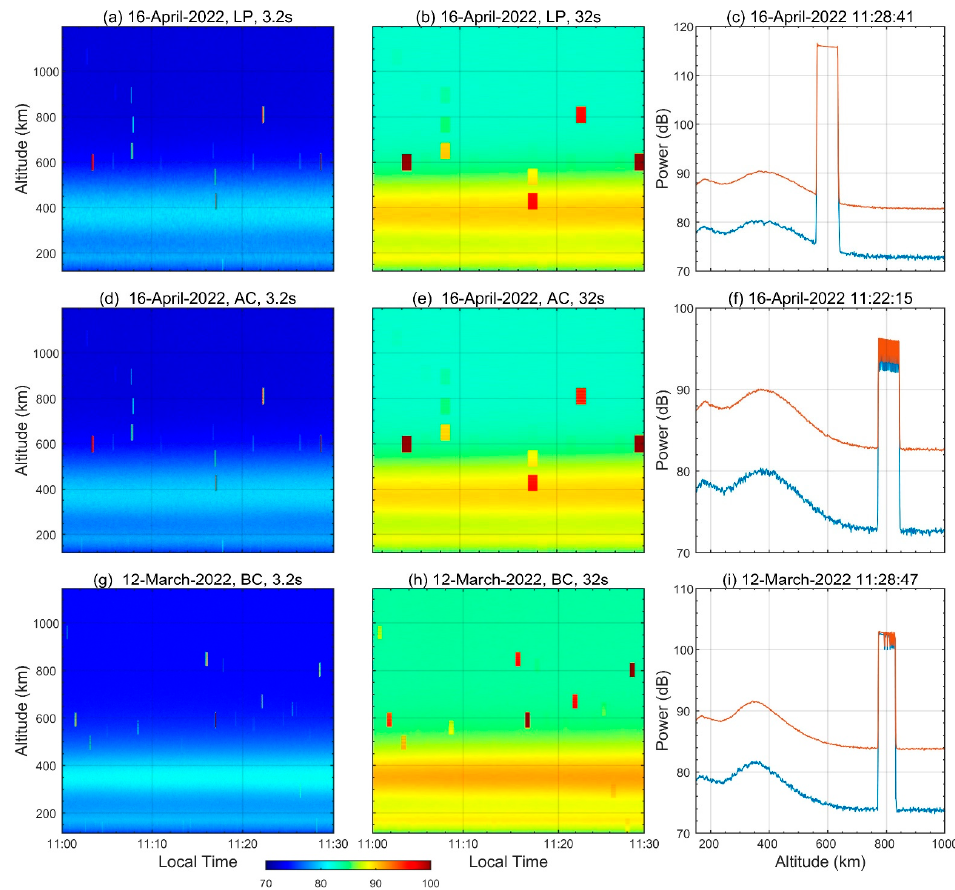
Figure 1. Range-time-intensity (RTI, unit: dB) of the SYISR observations with different integration times (3.2 s in the left column, 32 s in the middle column) during half-hour intervals of 2022-04-16 (upper and middle panels) and 2022-3-12 (lower panel). The right column is the corresponding power profile case with a space object pollution during a selected time (blue line: results with the 3.2-s integration, red line: results with the 32-s integration). The upper ( a – c ), middle ( d – f ), and bot- tom ( g – i ) panels are the long pulse (LP, 480 µs), 16-bit alternating code (AC, 480 µs) signal, and 13- bit barker code (BK, 390 µs) signal, respectively. The radar beam steered to the zenith direction ranging from 120 to 1200 km in all three experiments. During the ionospheric parameter retrieval from the ISR signal, the ACF is calculated after decoding [21–23]. The corresponding power spectra can be derived from the ACF through the Fourier transform. If the space object pollution is not eliminated properly in the original data, it will affect the ACF and power spectra calculation. As an example, Figure 2 shows the ACF and power spectra profiles derived from SYISR measurements on 2022-04-16 at 11:23:15. In this case, the space objects appear at altitudes of approxi- mately 381 km and 488 km. As indicated, the space object occurrence results in a strong